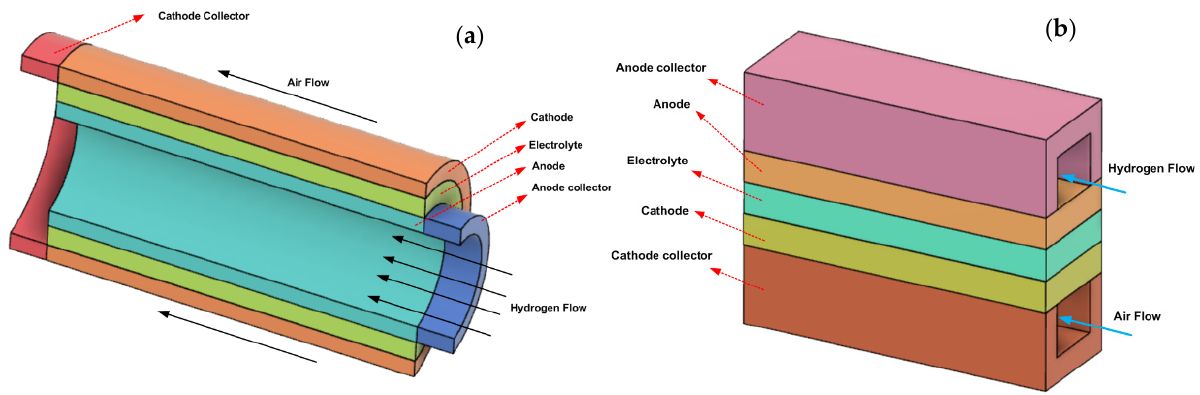
Figure 1. Solid oxide fuel cell: ( a ) tubular configuration; ( b ) planar configuration.